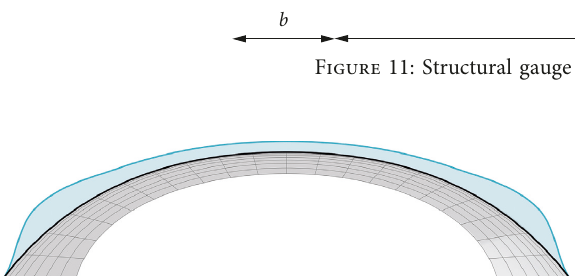
Figure 12: Curvature graph in the longitudinal direction.